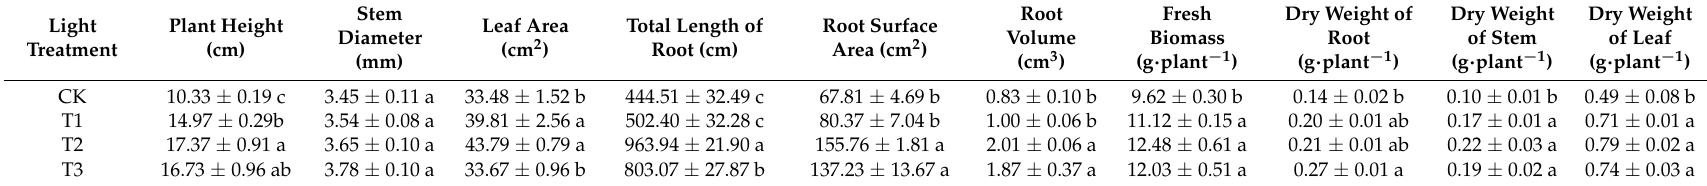
Table 2. Effect of supplementary light treatments on growth traits of pepper seedlings.